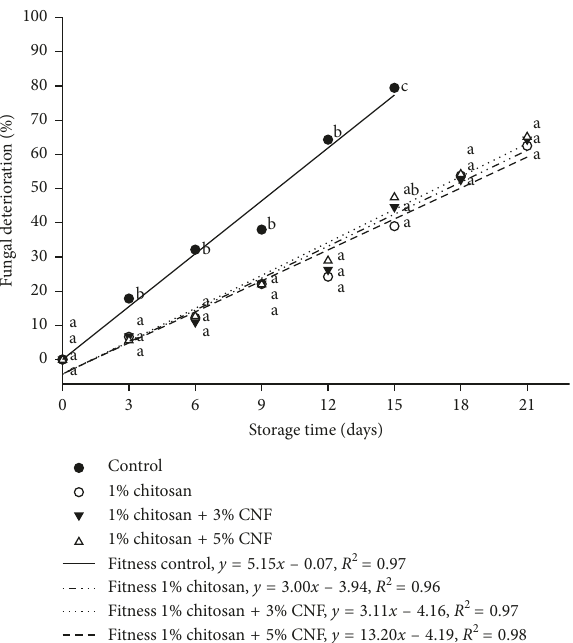
Figure 7: Average values in % of fungal contamination in strawberries with and without films during 21 days of storage. Same letters in the same storage time denote that averages do not differ by the Tukey test at 5%